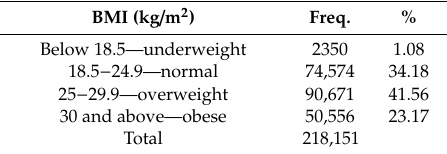
Table A2. BMI (frequency and percentages).